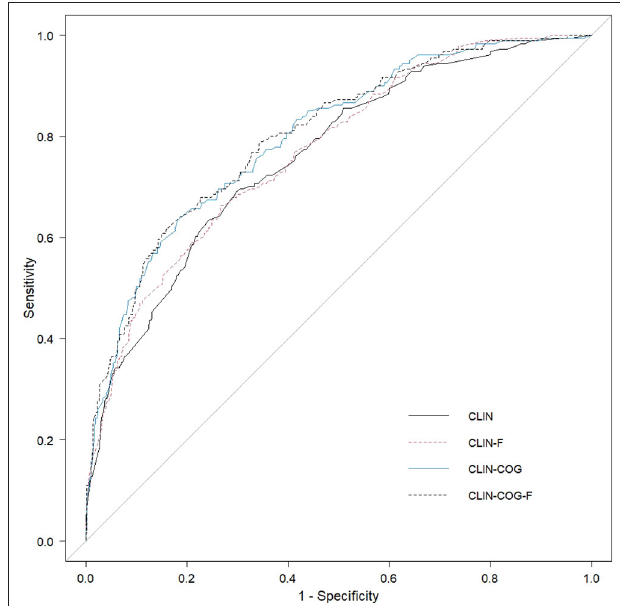
FIGURE 2 | Comparison of ROC curves constructed for all models. The clinical model (CLIN) included the seven clinical variables, model CLIN-F encompasses the dichotomized frailty index, and models CLIN-COG and CLIN-COG-F include cognition as well.